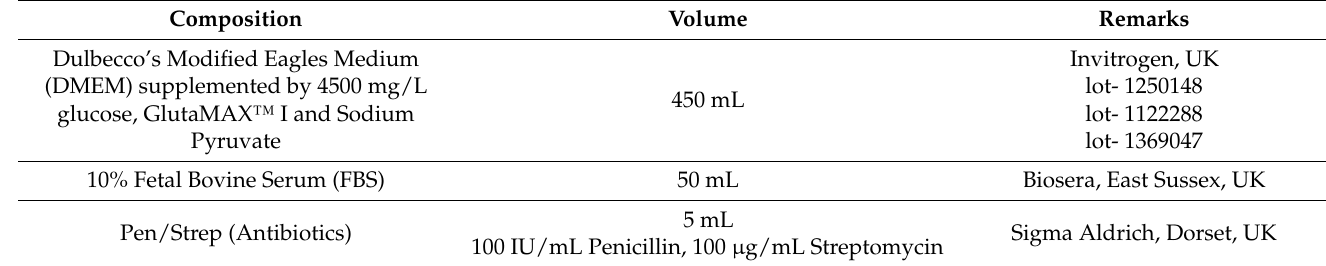
Table 2. Medium used for growing primary cells and SCC4 cell